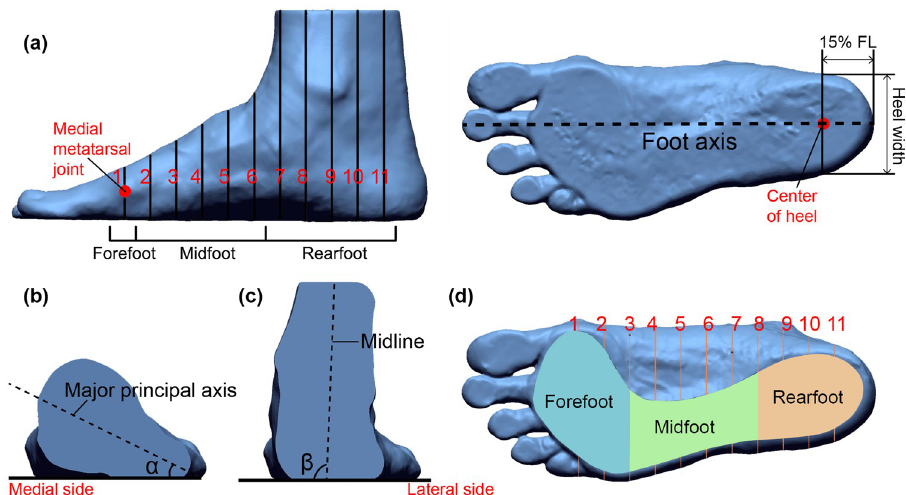
Fig 5. Foot segmentation and angles α and β : (a) foot is divided into 10 sections (from medial metatarsal joint to the center point of heel); (b) cross section in the midfoot and α (the angle between the major principal axis of mid foot cross section and the floor); (c) cross section in the rearfoot region and β —inclination of midline; and (d) outline and division of the contact area (plantar view).